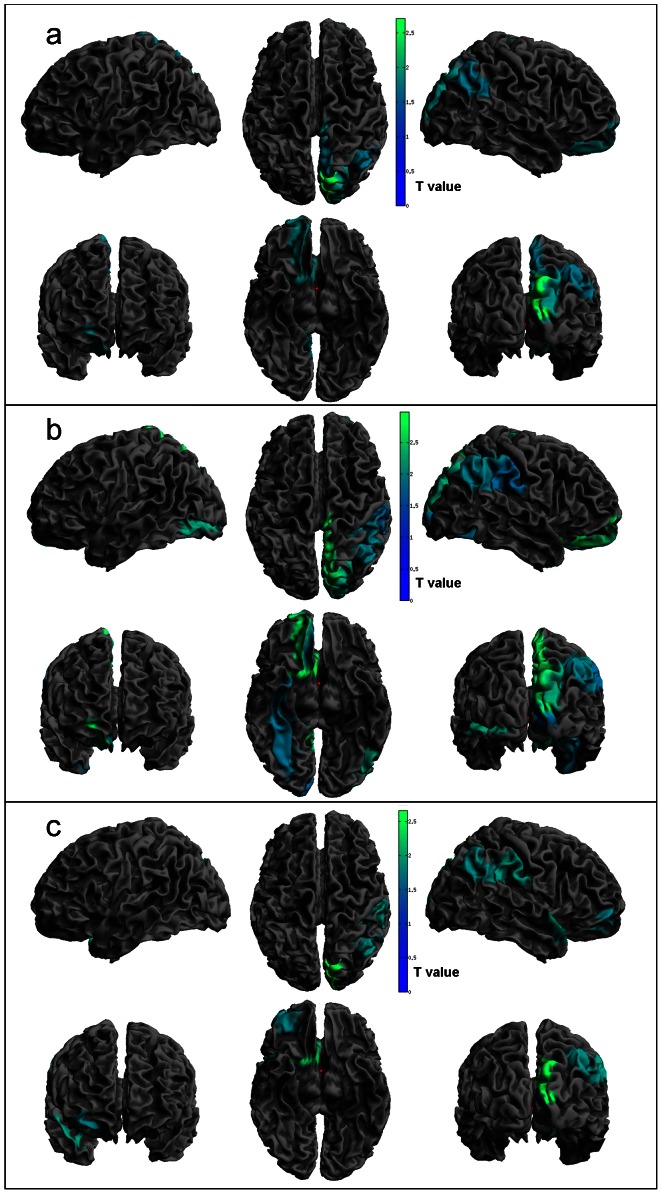
Regions of significant cortical thinning.Statistical threshold used T = 1.69, p<0.05. Panel a) PD vs. HC contrast; b) PD-CNT vs. HC; c) PD-MCI vs. HC.